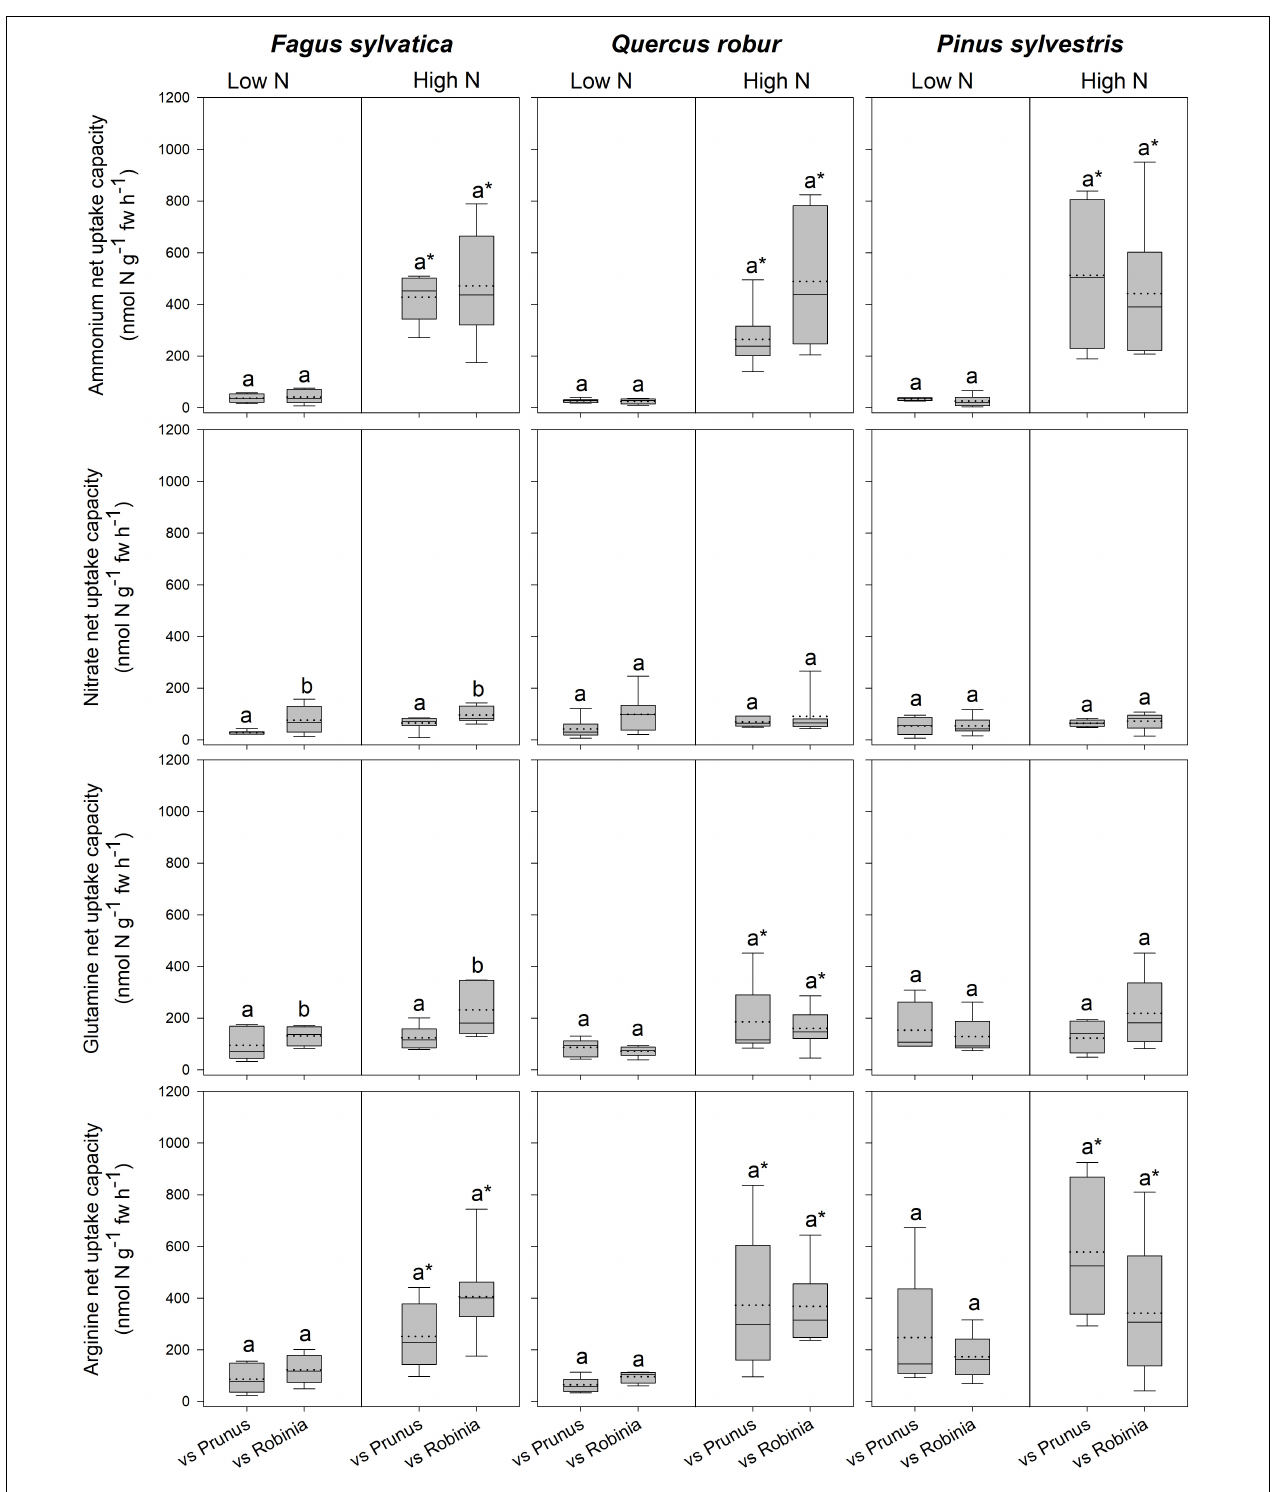
FIGURE 1 | Ammonium, nitrate, glutamine-N, and arginine-N net uptake capacity (nmol N g − 1 fw h − 1 ) by fine roots of Fagus sylvatica , Quercus robur, and Pinus sylvestris seedlings at low and high soil N availability under different competition regimes. vs. Prunu s = competition with Prunus serotina ; vs. Robinia = competition with Robinia pseudoacacia . Box plots show mean (dotted line) and median (continuous line). Different letters indicate significant differences between competition regimes within a specific soil N availability treatment, and asterisks indicate significant differences between soil N availability treatments detected using permutational analysis of variance ( p <